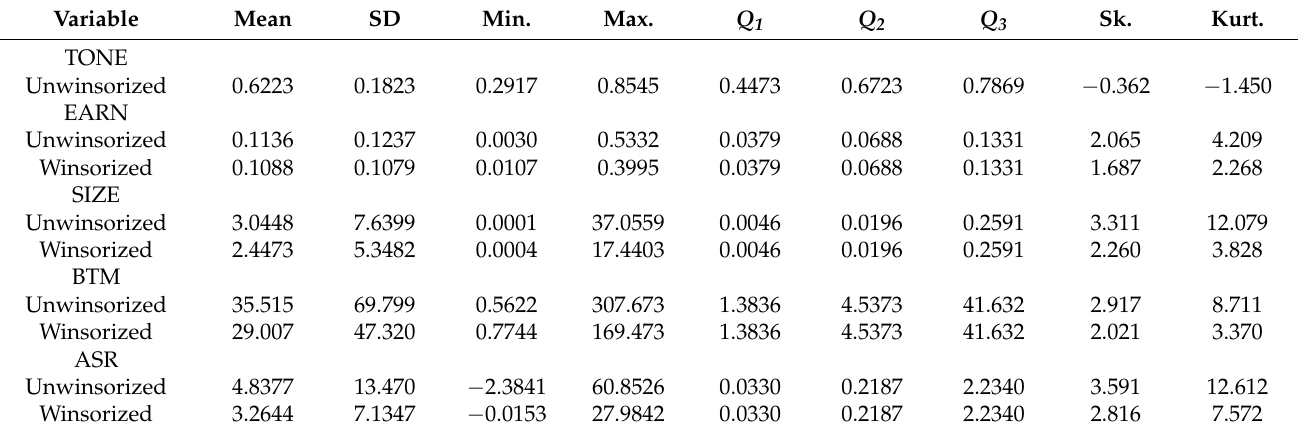
Table 3. Descriptive statistics.